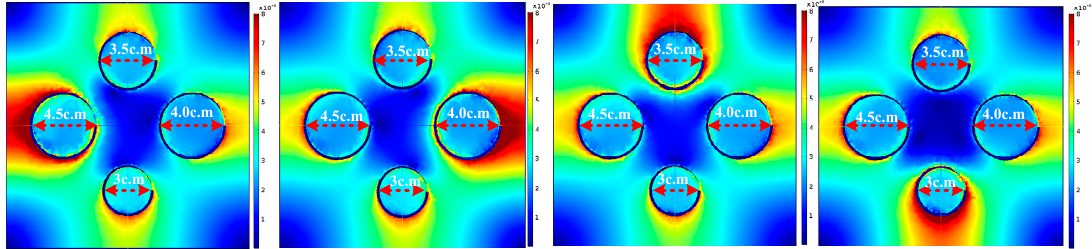
Figure 10. Magnetic field Intensity of Selective Power Transfer without compensation.